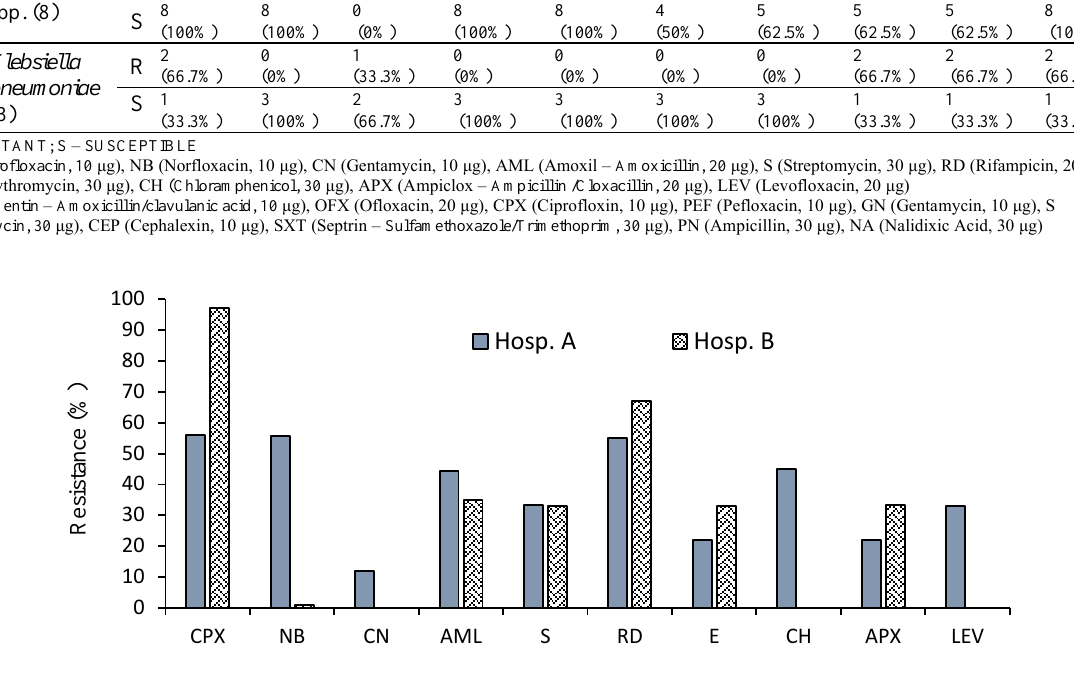
Fig. 2. Observed resistance in gram-positive bacterial isolates (CPX: ciprofloxacin, 10 μg; NB: norfloxacin, 10 μg; GN: gentamicin, 10 μg; AML: amoxil-amoxicillin, 20 μg; S: streptomycin, 30 μg; RD: rifampicin, 20 μg; E: erythromycin, 30 μg; CH: chloramphenicol, 30 μg; APX: ampiclox-ampicillin/cloxacillin, 20 μg; LEV: levofloxacin, 20